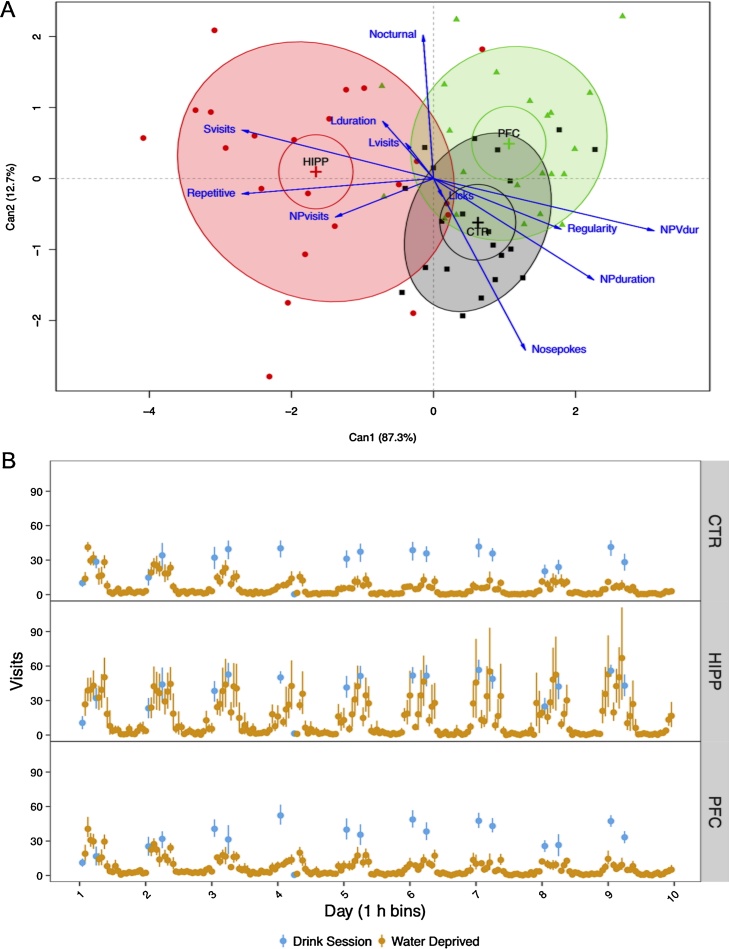
Measures of spontaneous behavior and synchronization of activity with drinking sessions discriminate experimental groups, as determined during Free Adaptation in both batches, and first Drink run of Les2, respectively (see Fig. 2). A) Canonical discriminant scores of individuals, means and 68% coverage probability ellipses for groups, and correlations of behavioral variables (see Fig. 2) with canonical components. The first canonical component clearly separates HIPP mice from the other groups, while the second canonical component further separates CTR and PFC with some overlap. B) Visits per hour during deprived (light) and drink access (dark) hourly periods (means with bootstrapped 95% CI). The eighth drinking session was unintentionally skipped due to an experimental error. Note that synchronization is strongly hampered in HIPP mice.